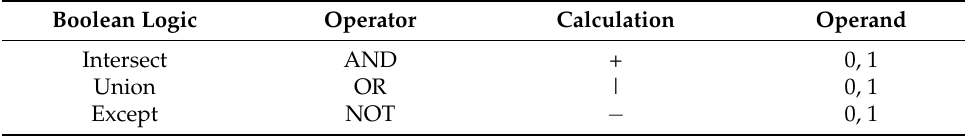
Table 1. Boolean logic and operational